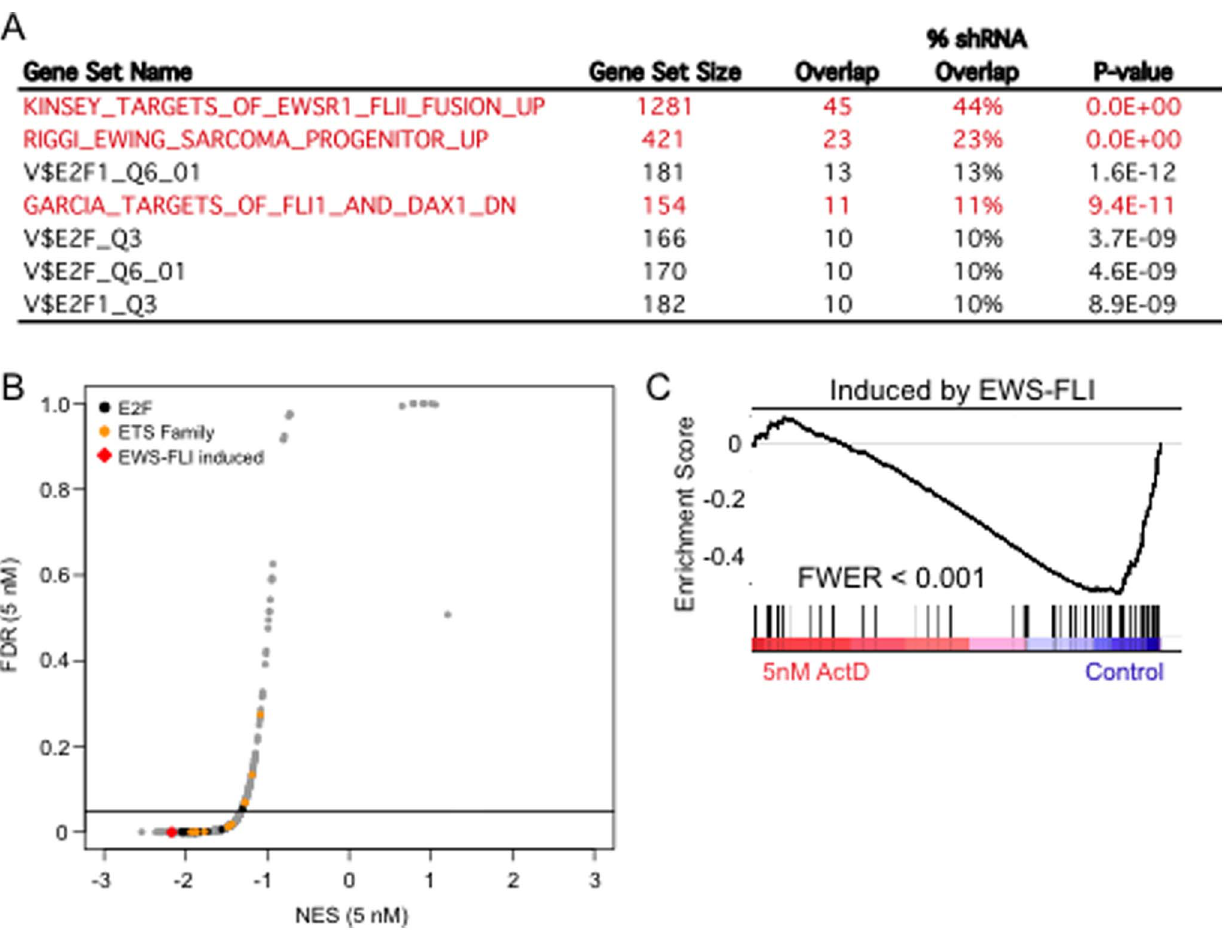
Figure 3. Effects of actinomycin D on EWS-FLI1 target gene expression. A. Genes down-regulated at least 2-fold by shRNA against EWS-FLI (adjusted p-value , 0.01) were used to interrogate curated (C2 pathways, C5 gene ontology) and predicted (C3 transcription factor) gene sets. Shown are overlapping gene sets that encompassed at least 10% of the 102 EWS-FLI signature genes represented in MSigDB. B. Plot of normalized signature enrichment score vs FDR from GSEA using transcription factor signatures to distinguish cells treated with 5 nM actinomycin D from control. Subsets of signatures for E2F and ETS-family members are highlighted for comparison with gene sets induced or repressed by EWS-FLI. C. GSEA plot showing the down-regulation of EWS-FLI target genes by treatment with 5 nM actinomycin